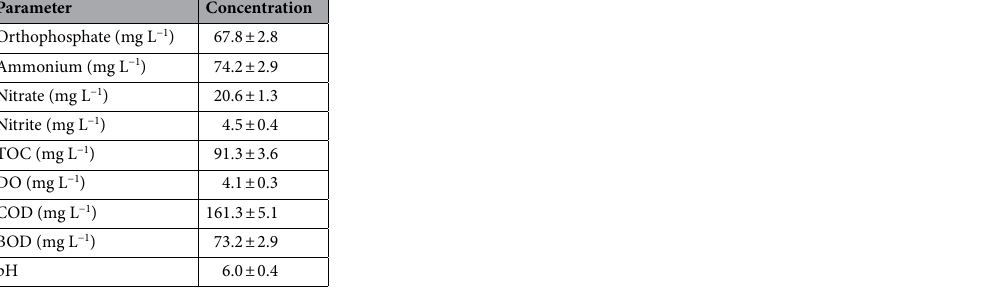
Table 5. Characteristics of APL medium. Values were calculated as the mean (± SE) of three independent observations, i.e., n = 3.